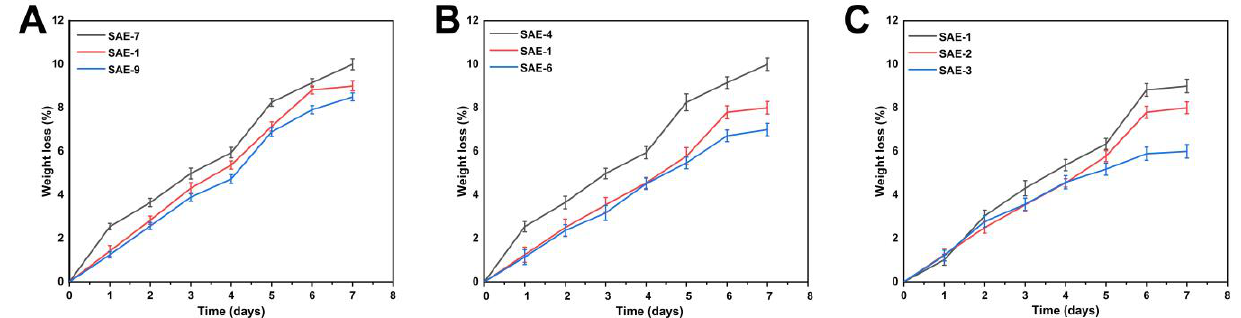
Figure 7. Effect of ingredients on the biodegradation of hydrogels: sodium alginate (SAE-7,1,9) ( A ), AMPS (SAE-4,1,6) ( B ), and EGDMA (SAE-1,2,3) ( C ) on the in vitro biodegradation of the developed hydrogels.